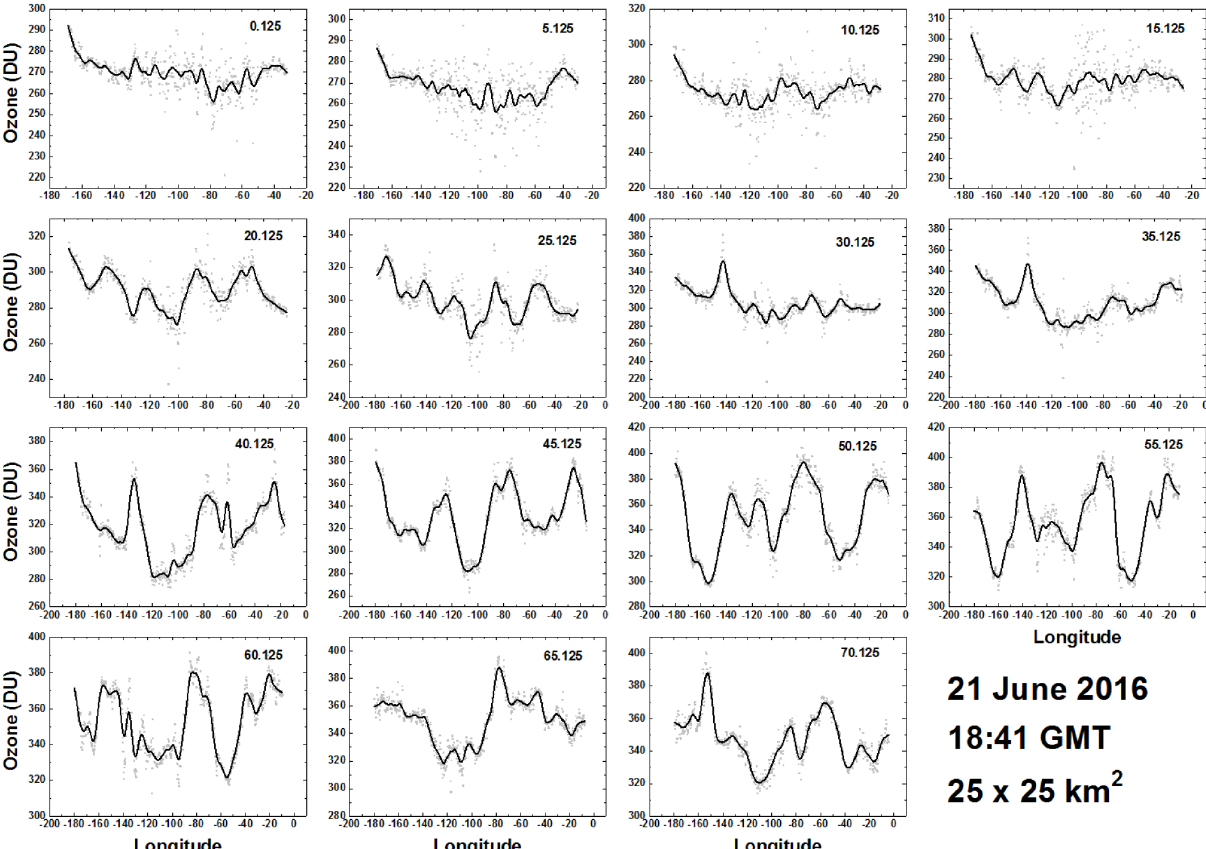
Figure 13. Longitudinal or diurnal variation of ozone for the Northern Hemisphere every 5 ◦ from 0 to 70 ◦ for 21 June 2016 at 18:41 UTC. The grey bands are the individual data points in the band. The solid lines are a LOWESS(0.05) fit to the data points representing a solar time average from 0.6 to 0.7h depending on latitude. The SZA is limited to ± 70 ◦ . Longitude = 0 corresponds to 18:41 local time, and longitude =− 180 corresponds to 06:41 local